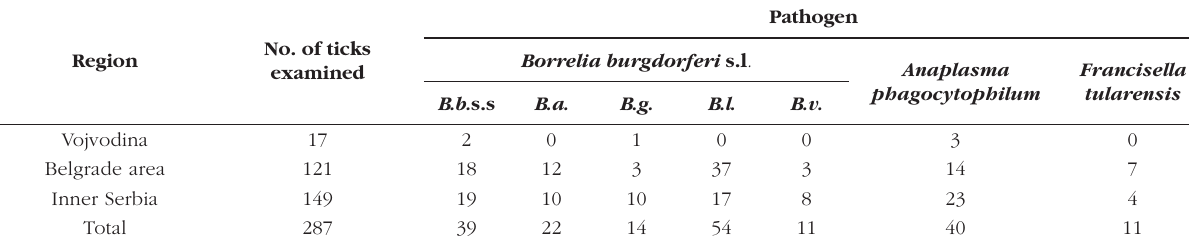
Table I. – Prevalence of B. burgdorferi s.l., A. phagocytophilum , and F. tularensis in adult I. ricinus ticks from